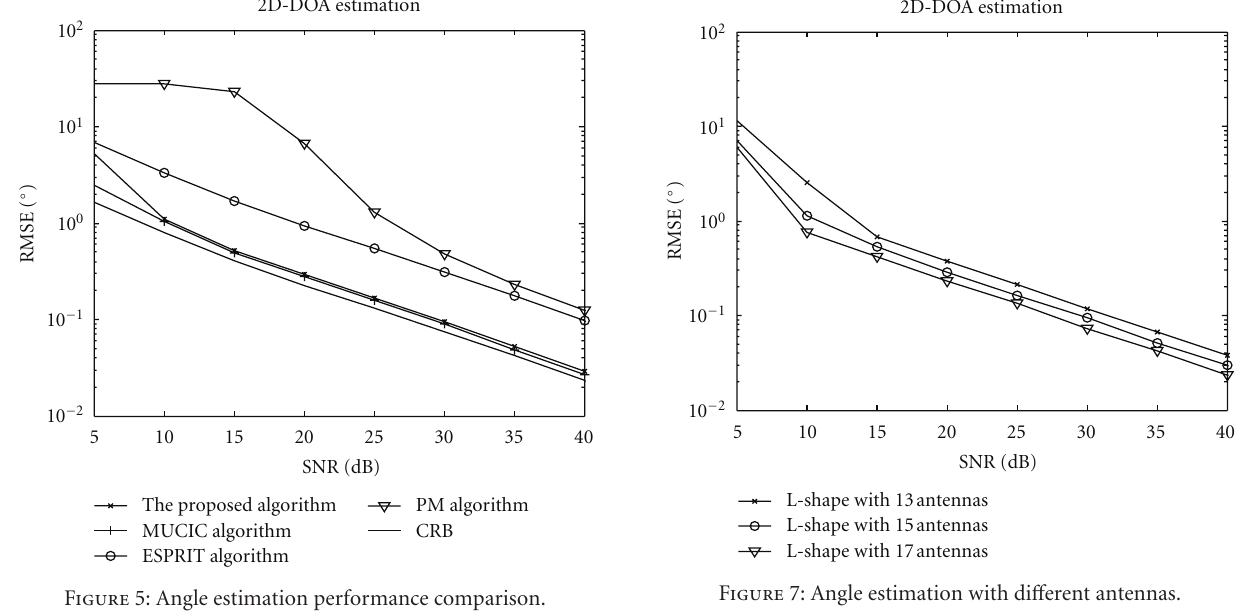
Figure 5: Angle estimation performance comparison.